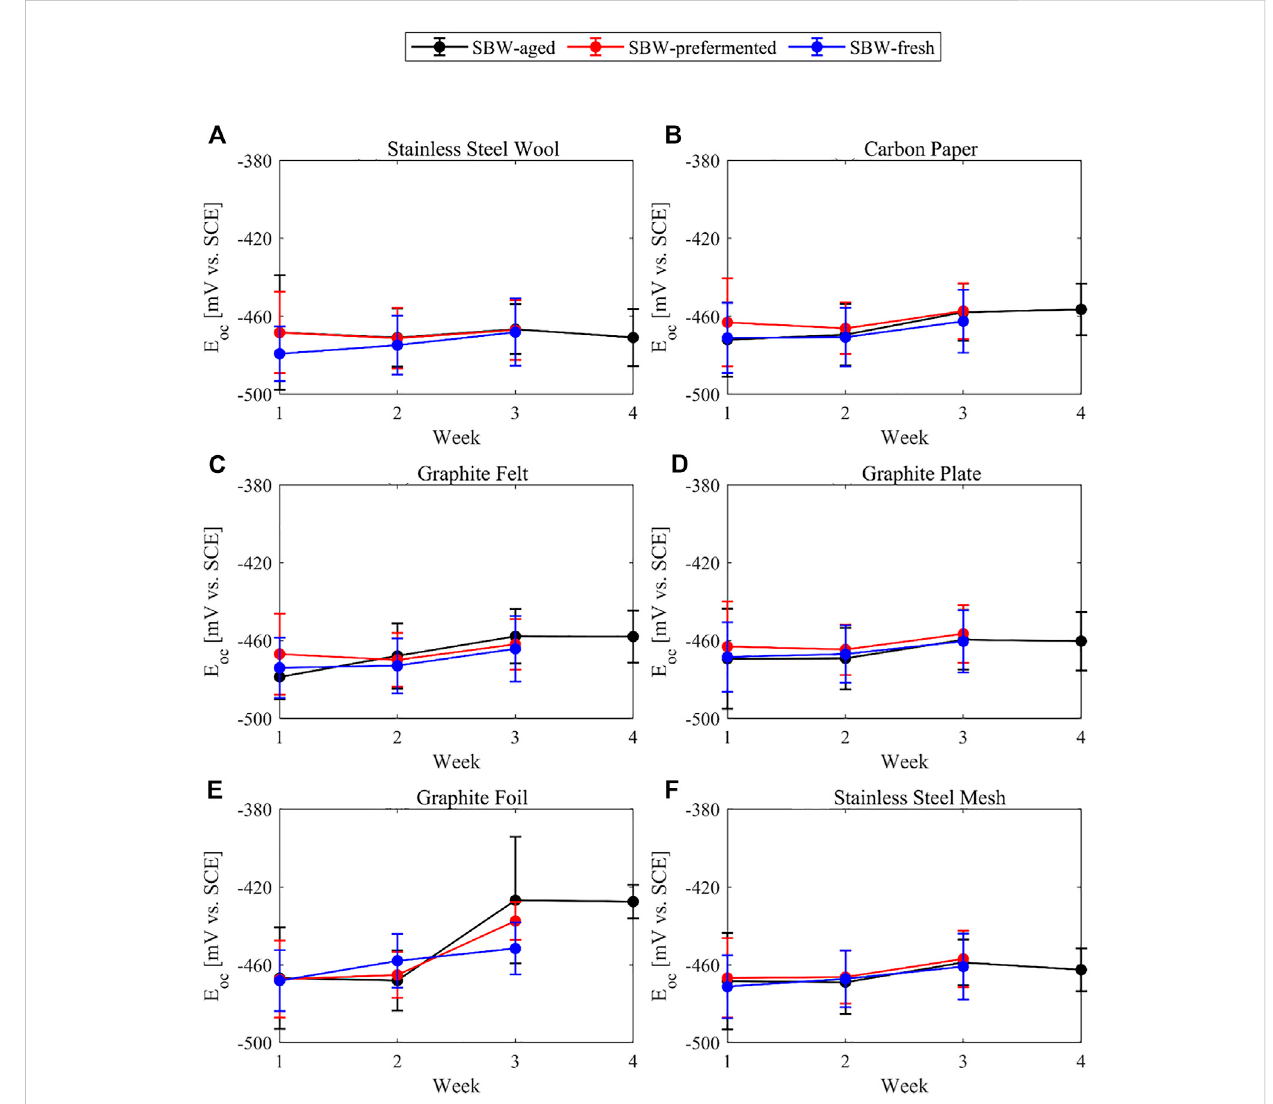
Open circuit potential of the bioanodes against the reference electrode over the weeks of the experiment and bound with lines for visual aid. (A) Stainless-steel wool (B) Carbon paper (C) Graphite felt (D) Graphite plate (E) Graphite foil (F) Stainless-steel